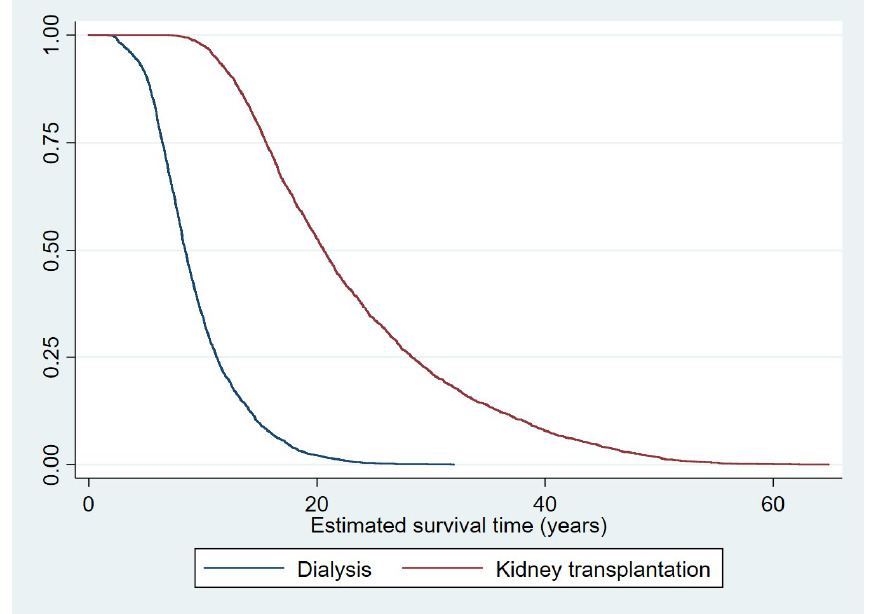
Figure 2. Kaplan–Meier estimated survival curve by treatment groups for main analysis.